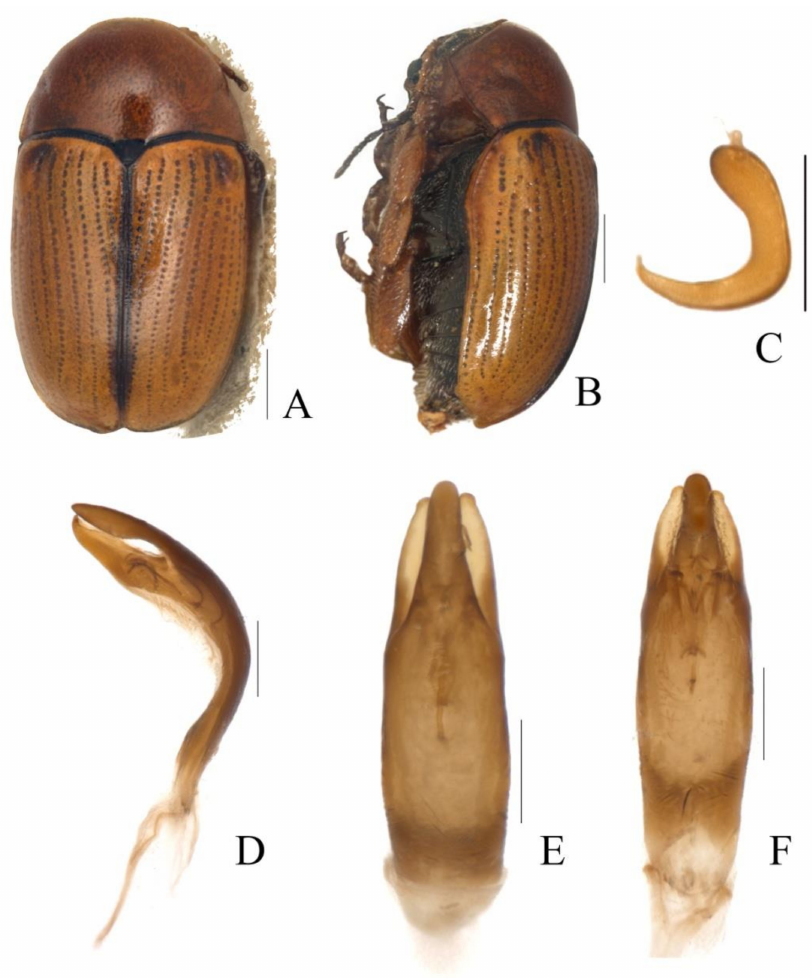
Figure 2. Cryptocephalus ( Burlinius ) longchiensis Duan & Zhou, sp. nov.: ( A ) habitus; ( B ) lateral view of habitus; ( C ) spermatheca; ( D ) lateral view of aedeagus; ( E ) dorsal view of aedeagus; ( F ) ventral view of aedeagus. (Scale bars: ( A , B ) = 0.5 mm, ( C – F ) = 0.2 mm) (( A , B , D – F ) holotype, male; ( C ) paratype, female).